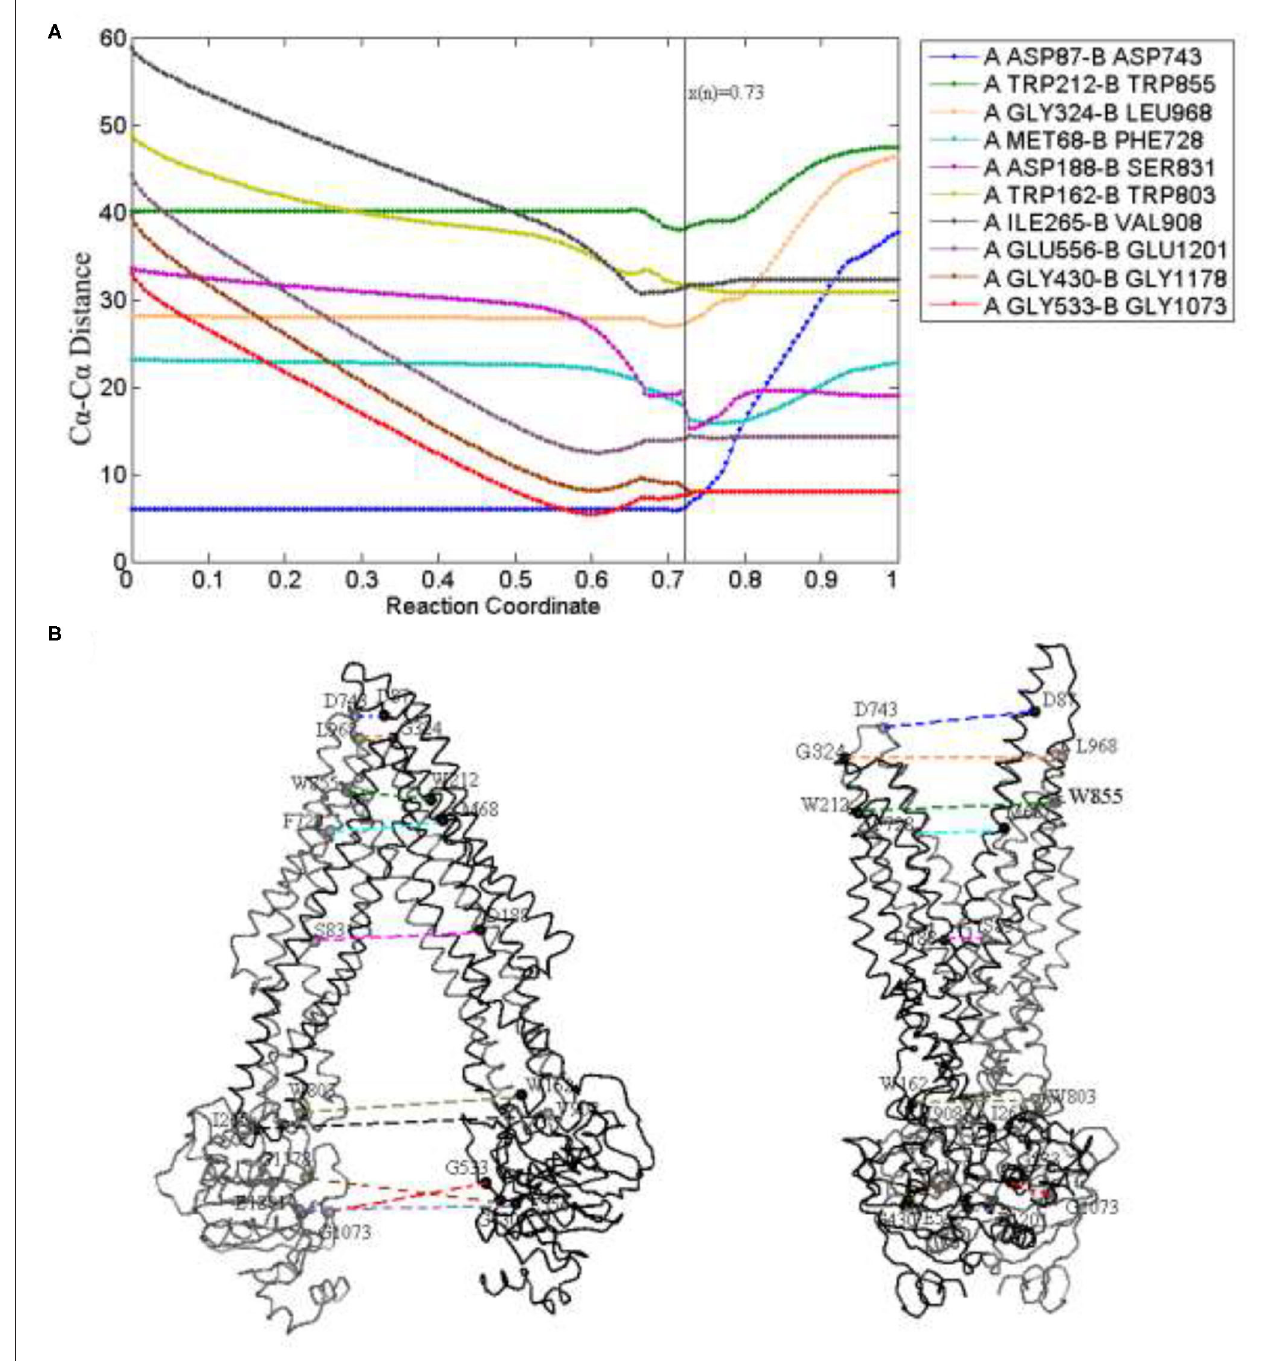
FIGURE 5 | Distance changes (A) of some critical residue pairs (B) along the reaction coordinate. x ( n ) = 0.73 (black) is the reaction coordinate of the transition state. The color of lines in (B) is in correspondence to (A) .